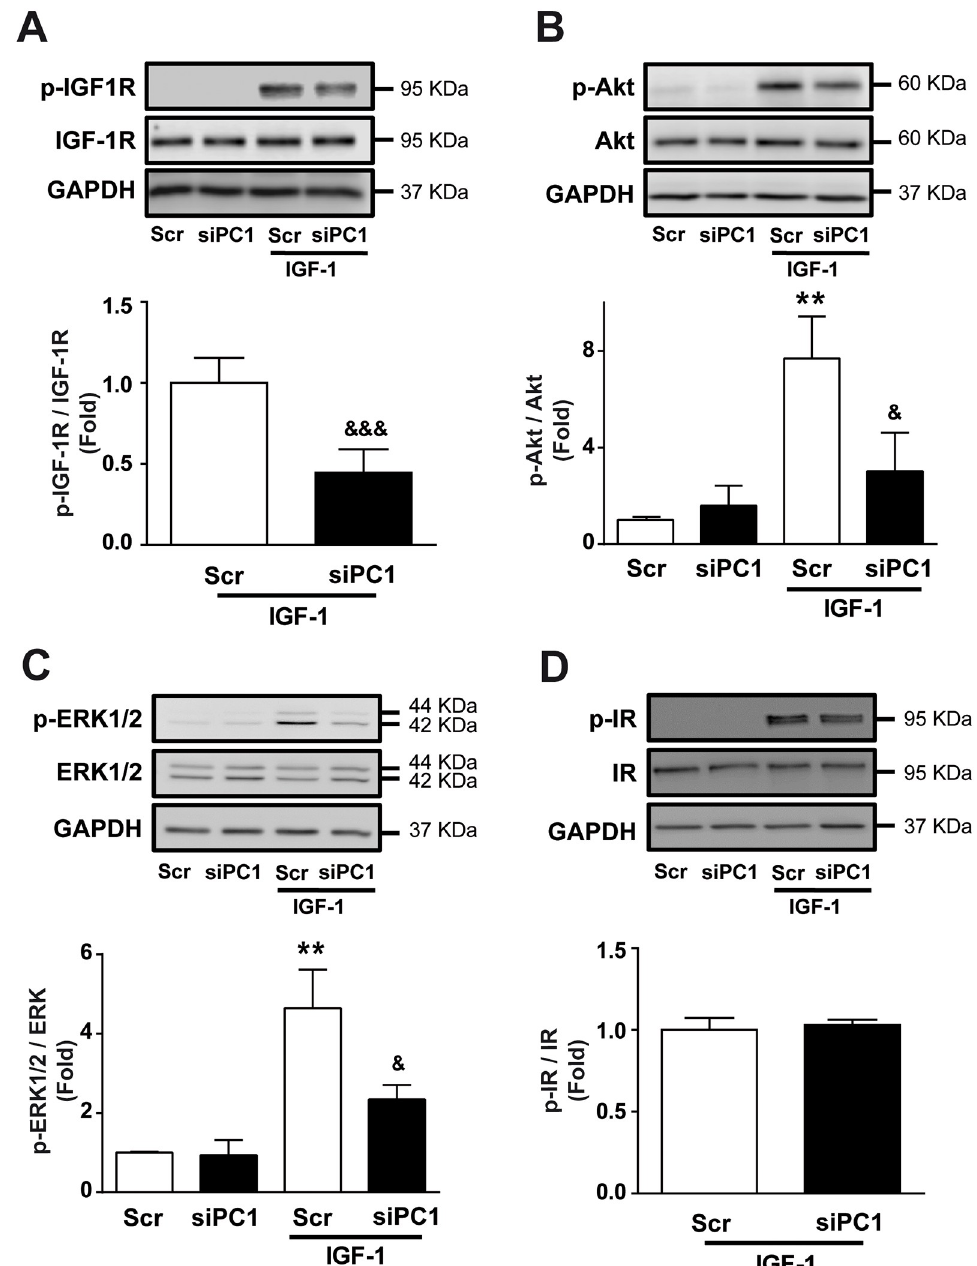
Fig 3. PC1 regulates IGF-1-dependent IGF-1R activation. Cardiomyocytes were transfected with scrambled (Scr) or PC1 siRNA (siPC1), incubated for 24 h, and then stimulated with IGF-1 (10 nM) or vehicle for 5 min. Upper panels are representative Western blots of (A) phosphorylated IGF-1R (p-IGF-1R) and total IGF-1R, (B) phosphorylated Akt (p- Akt) and total Akt, (C) phosphorylated ERK1/2 (p-ERK1/2) and total ERK1/2 and (D) phosphorylated insulin receptor (p-IR) and total IR. Lower panels show the (A) p-IGF1R/IGF-1R, (B) p-Akt/Akt, (C) p-ERK1/2/ERK1/2, and (D) p-IR/IR ratios. GAPDH was used as a loading control. Values are shown as mean ± SD (n = 3–6). �� p < 0.01 vs. Scr, & p < 0.05 and &&& p < 0.001 vs. Scr+IGF-1.